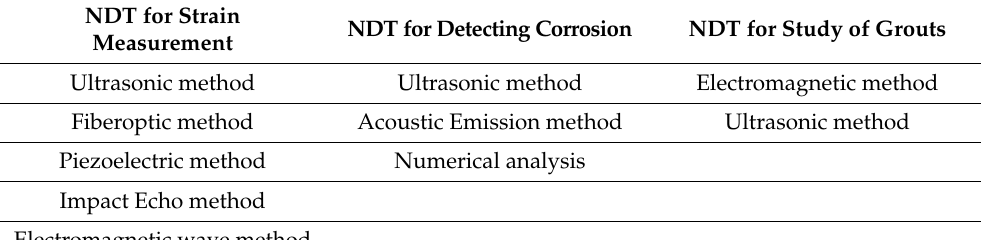
Table 1. Understanding Non-Destructive